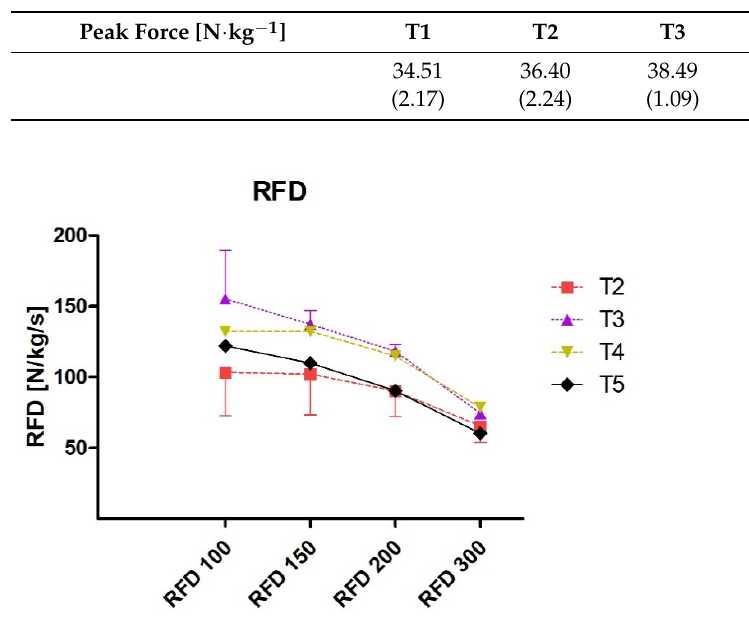
Figure 2. Rate of force development in 100, 150, 200 and 300 ms throughout 16-week training.